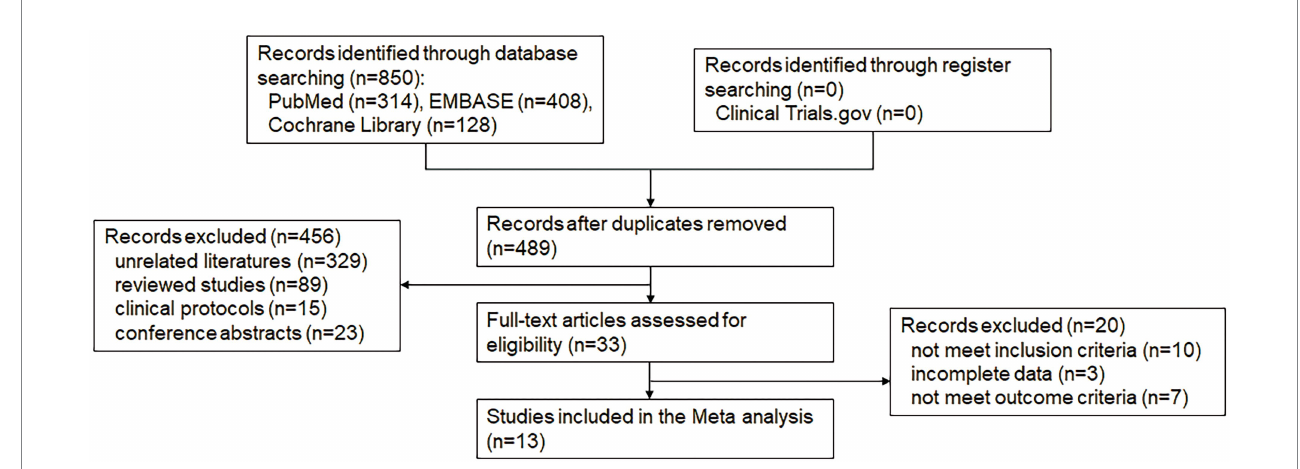
FIGURE 1 Flow diagram of the study selection